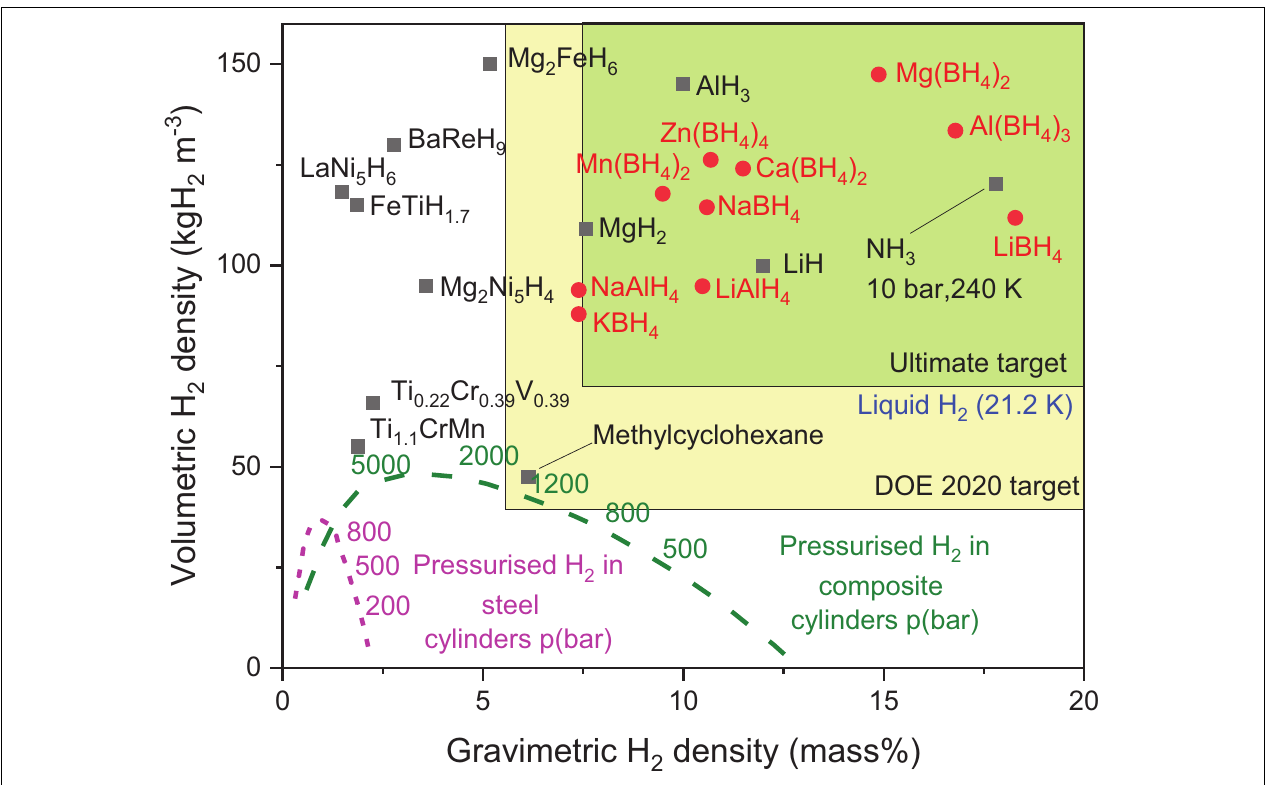
FIGURE 2 | Volumetric and gravimetric hydrogen density of few selected hydrides (Reprinted from Lai and Aguey-Zinsou (2018) and Valera-Medina et al. (2018)).